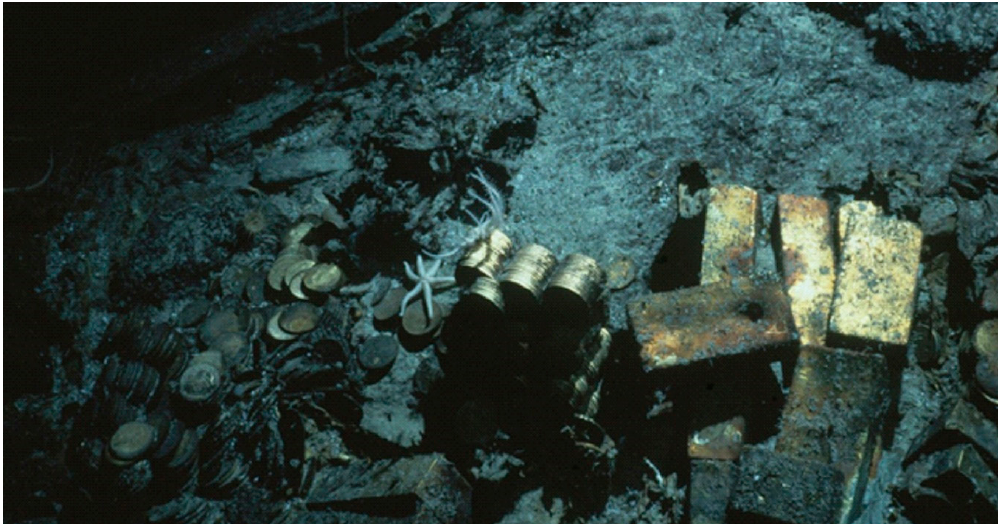
Figure 2. Seafloor image of gold from the shipwreck of the SS Central America . Note the formation of black crusts on the coins and some of the gold bars. These crusts appear black to grey in the image, due to constraints of seafloor lighting. Image courtesy of California Gold Marketing Group.